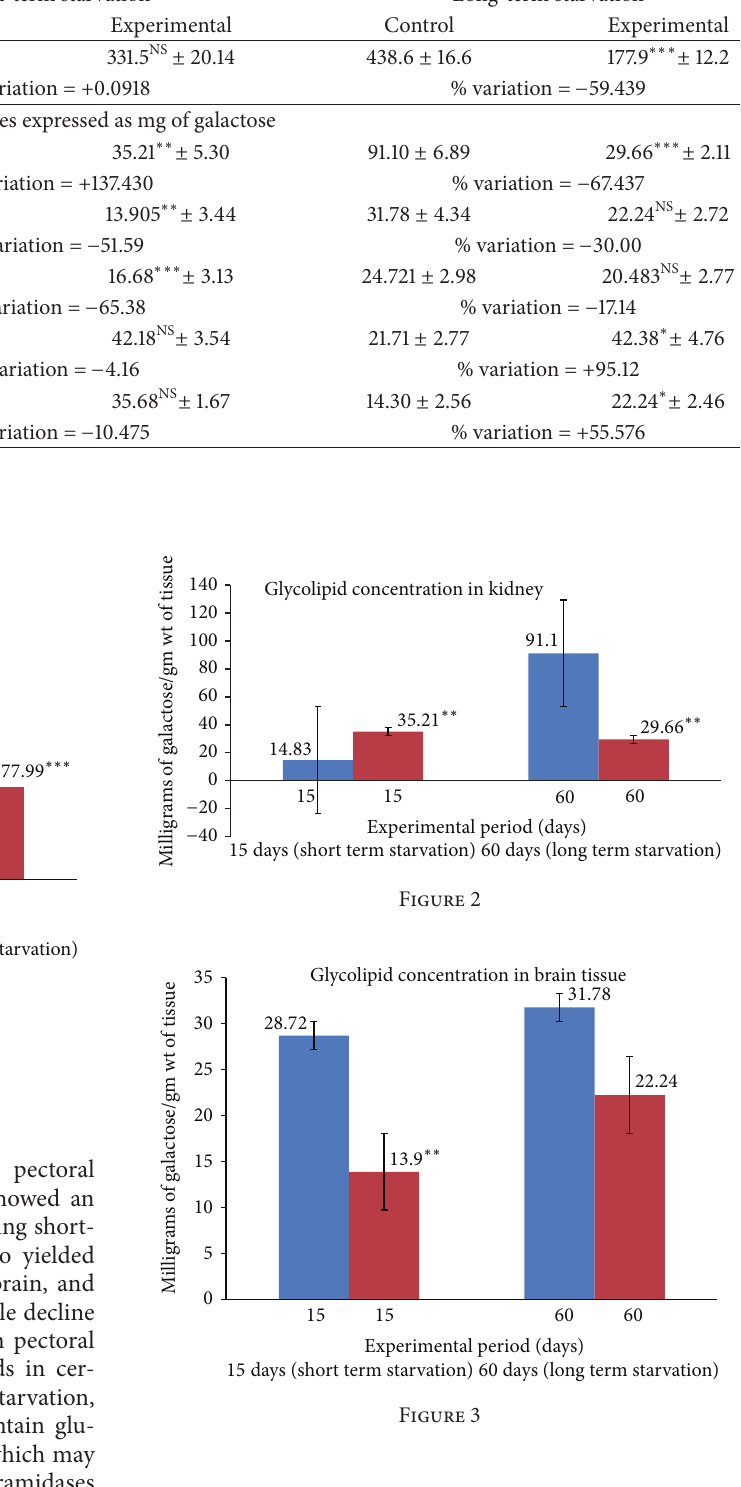
Table 1: Glycolipid levels in different tissues during short-term and long-term starvation in A. testudineus.